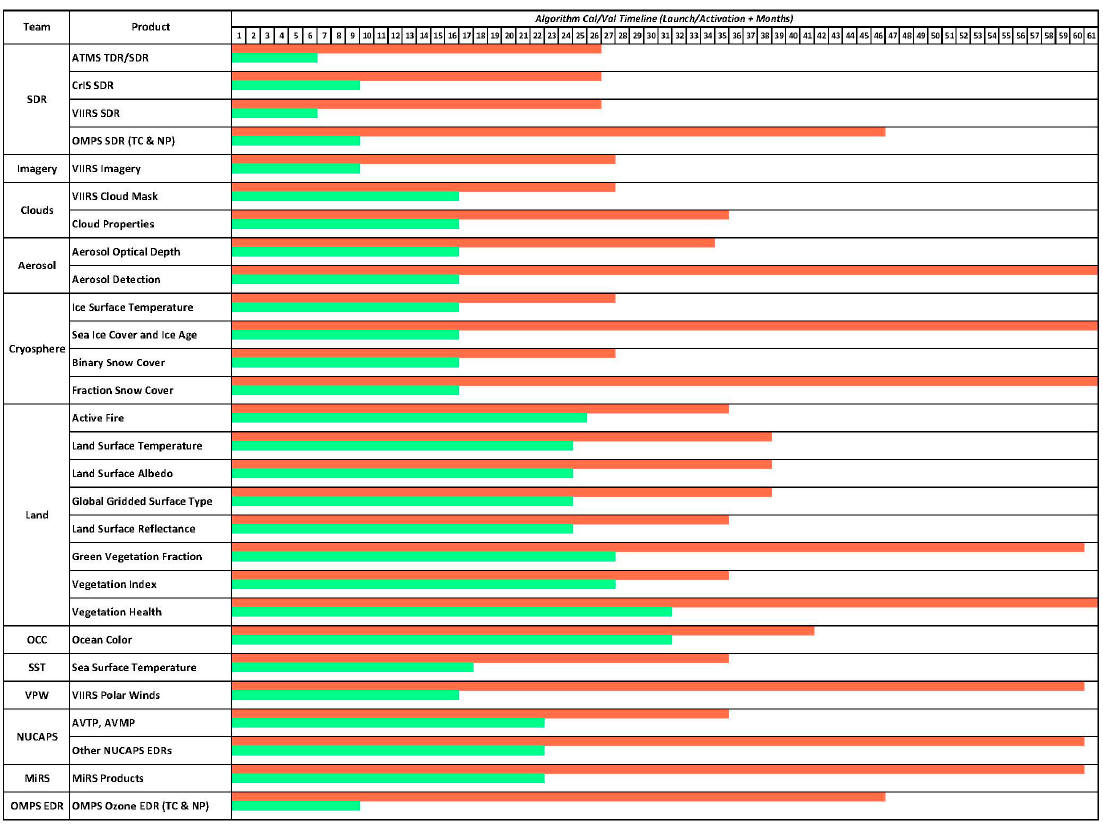
Figure 16. NOAA-20 validated maturity projections. The red (for S-NPP) and green (for NOAA-20) bars depict validated maturity timelines (Launch/Activation + Months). The lessons learned through S-NPP product maturity, adapting some of the Cal/Val tools developed through S-NPP, methodologies optimized in collecting the in situ measurements are helping to expedite the NOAA-20 validated maturity.